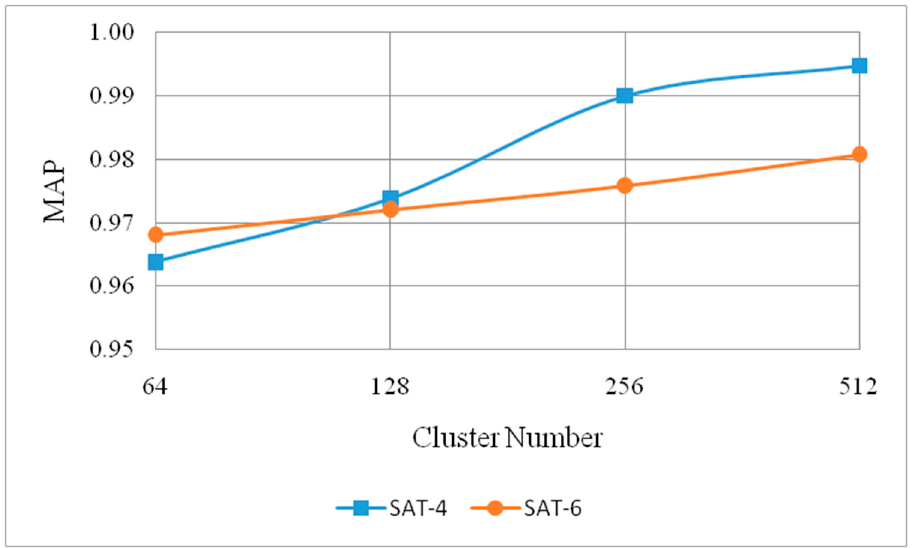
Figure 5. MAP score under different cluster numbers on SAT-4 and SAT-6 datasets.